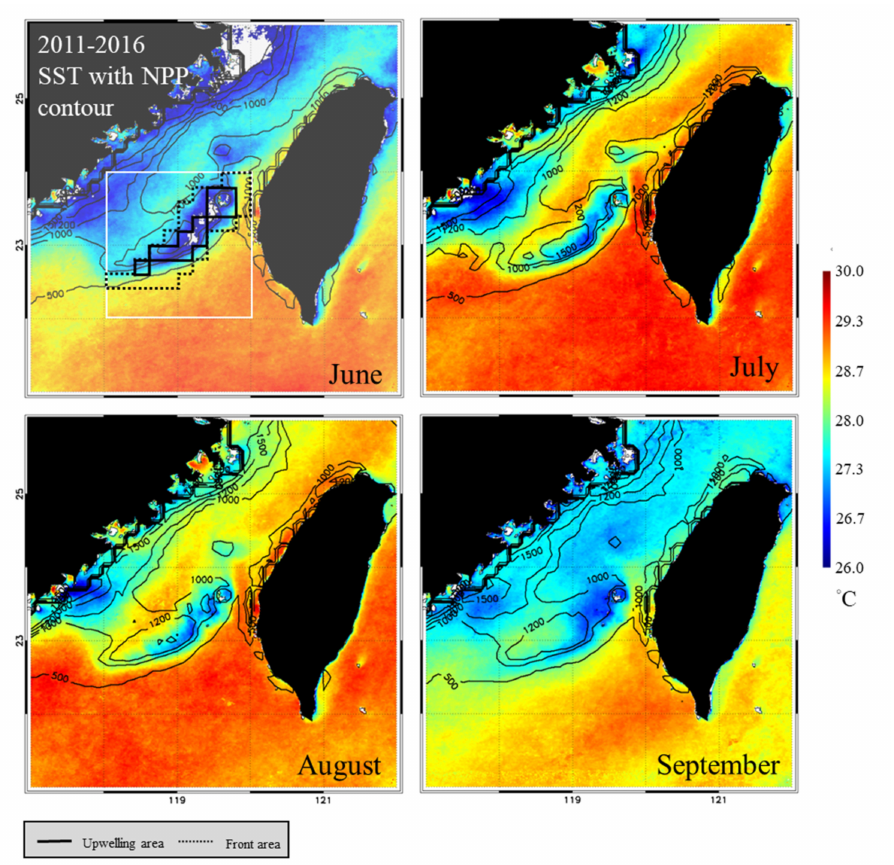
Figure 3. Spatial distributions of monthly sea surface temperature (SST) and net primary production (NPP) in the Taiwan Bank region. The areas circumscribed by solid and dotted black lines are the upwelling and thermal front habitats,